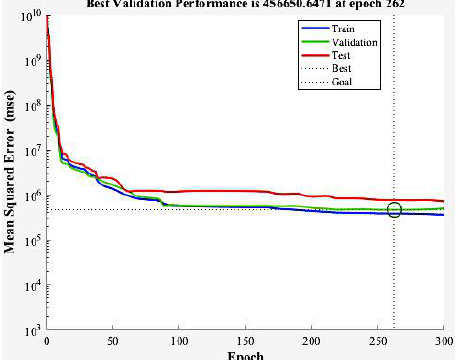
Fig. 7. Neural network training results of PD